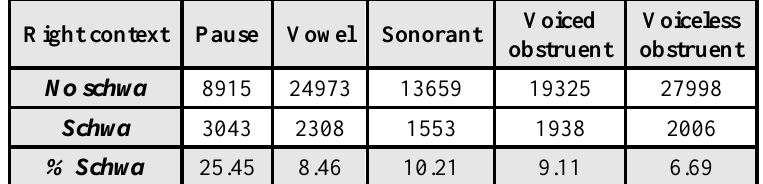
Table 5. Number of schwas for each right context (simplex coda before pause, vowel or simplex onset only, all corpora combined)